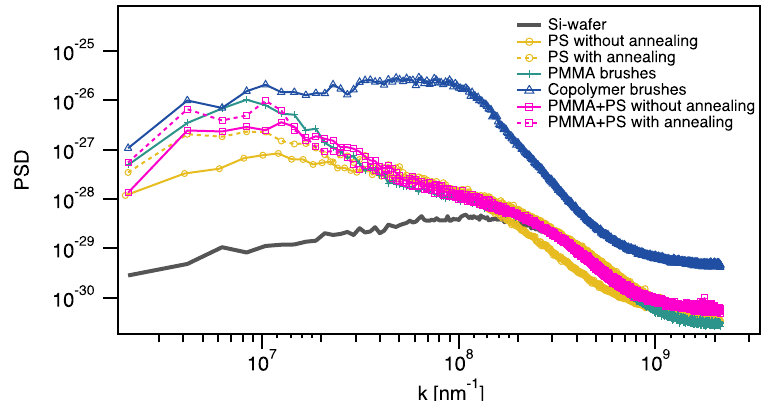
Figure 6. Radially averaged power spectral density of polymer thin films in comparison. PSDs were calculated from AFM topography